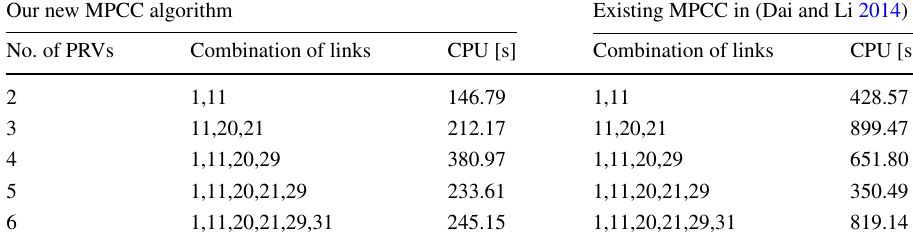
Our new MPCC algorithm